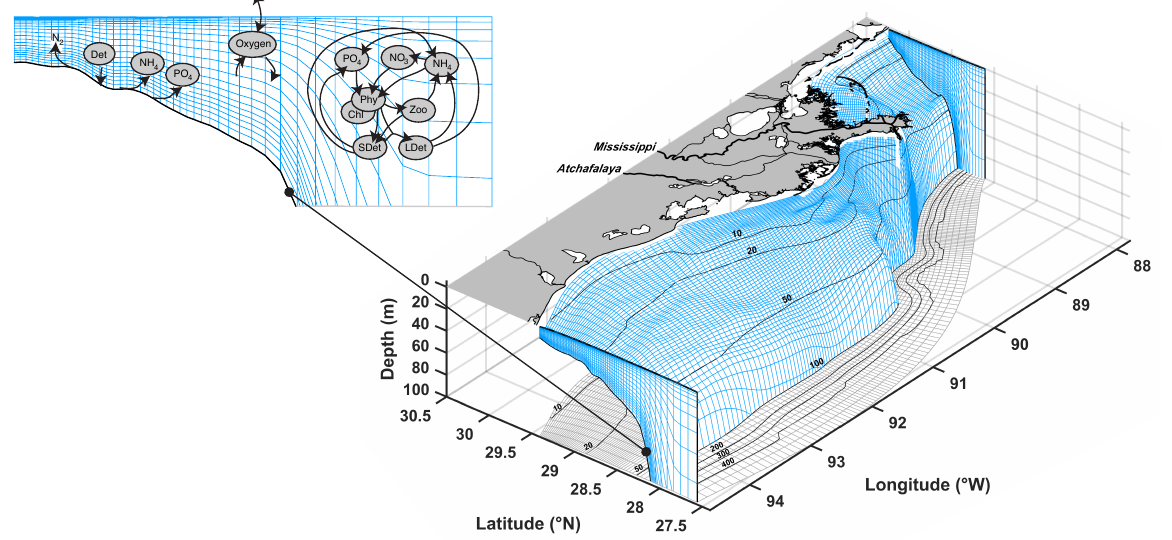
Figure 1. ROMS model grid and schematic representation of the biogeochemical variables and processes. The model domain extends to 1000m depth, but only the top 100m is